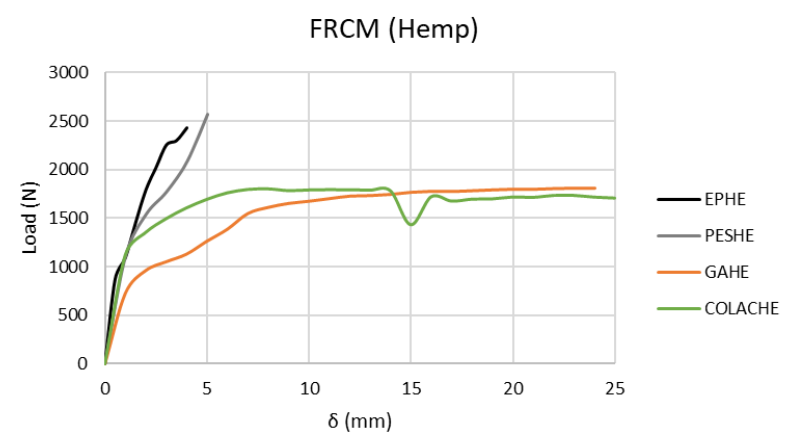
Figure 10. Load–Extensometer curves for hemp Figure 10. Load – Extensometer curves for hemp FRCM.